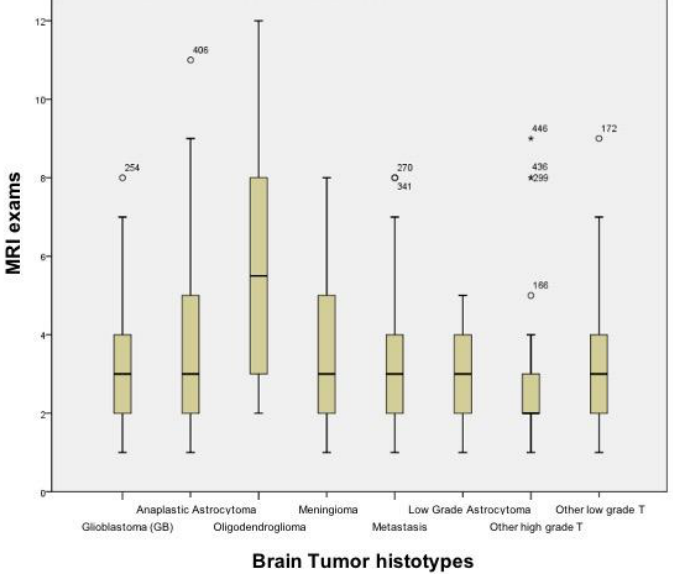
Figure 2. Box plots showing the distribution of the number of MRI exams revised at our nMTB, stratified by brain tumor histotype.